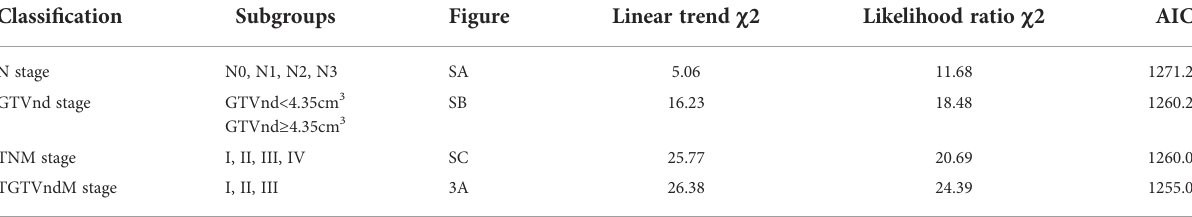
TABLE 5 Comparison of the prognostic performance of the TGTVndM and TNM staging systems. Classi fi cation Subgroups Figure Linear trend c 2 Likelihood ratio c